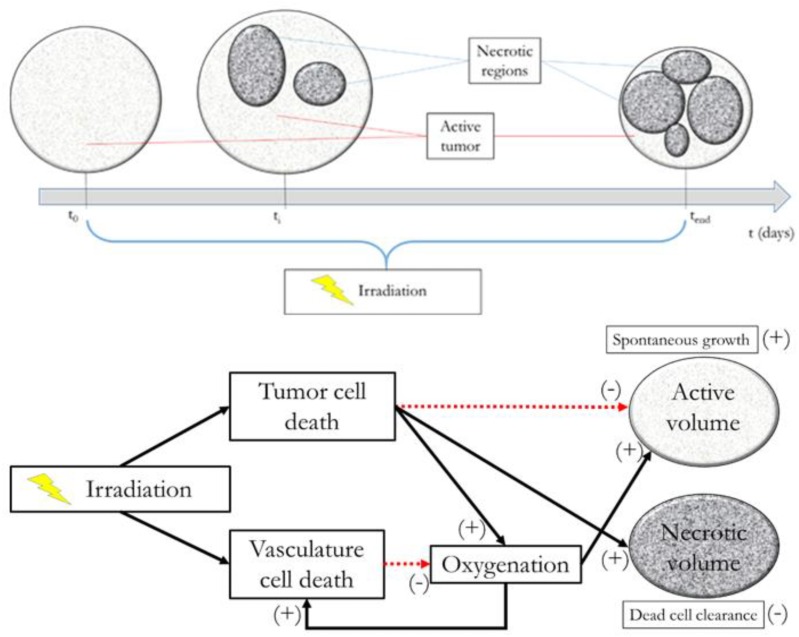
Model at glance. Upper panel: example of tumor evolution through time. Lower panel: active volume, necrotic volume, irradiation, and oxygenation interplay diagram.